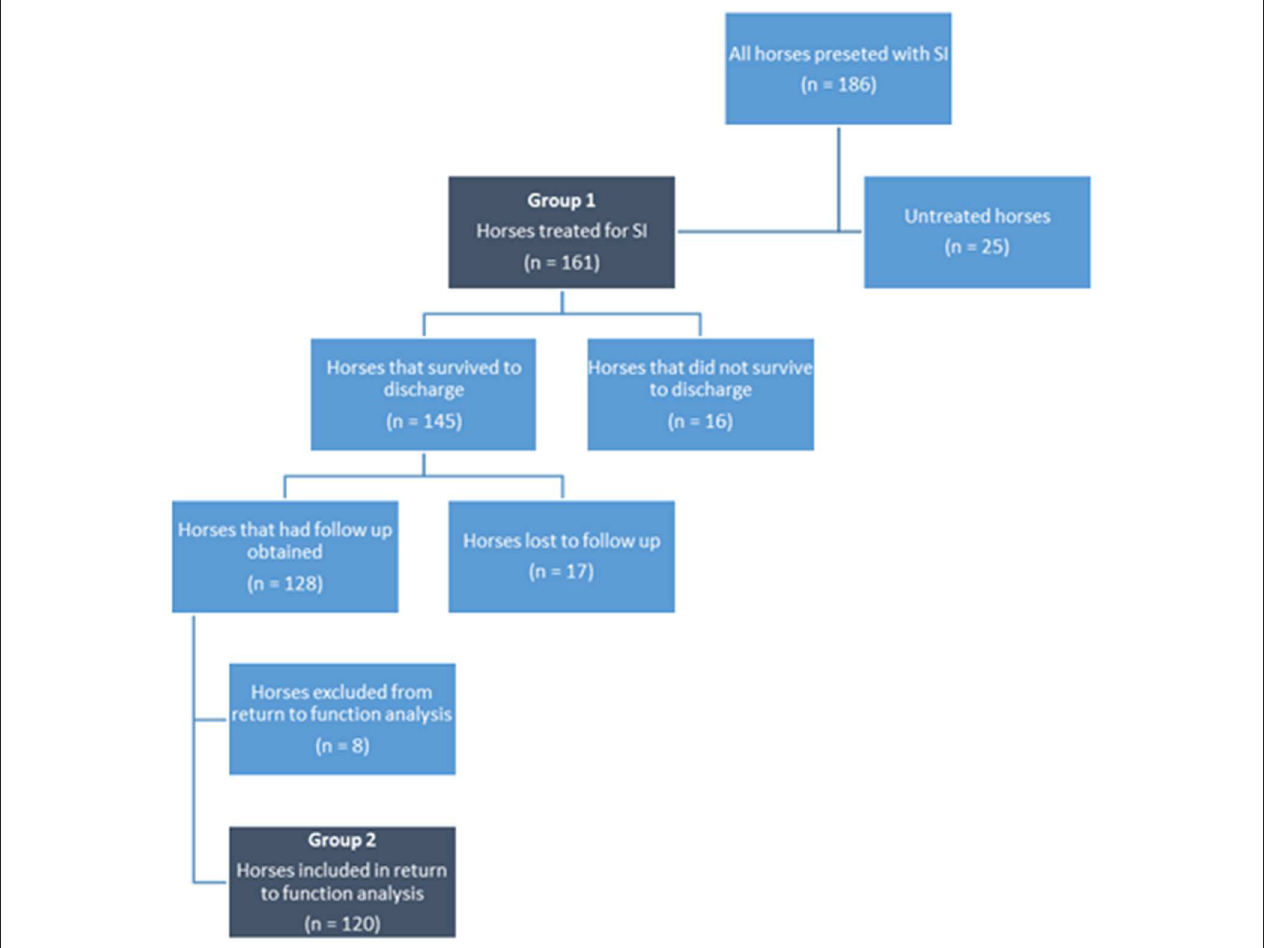
FIGURE 1 | Flow diagram illustrating the process to inclusion of horses and foals.